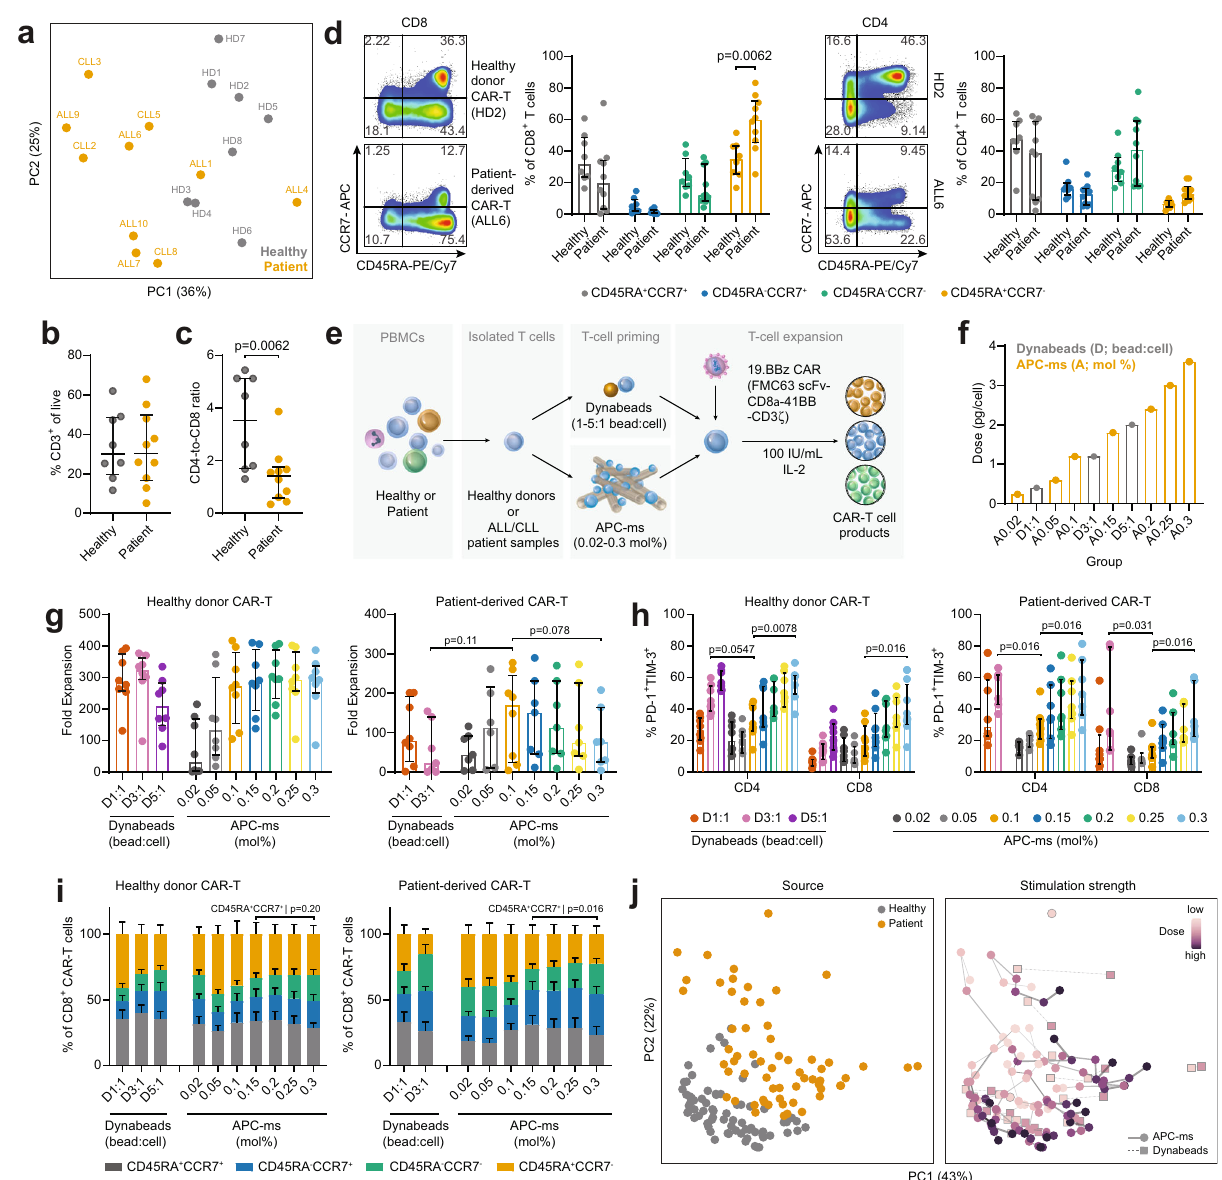
Fig. 1 | Stimulation strength and quality during T-cell activation drives the productionofdistinctCAR-Tcellproducts.a Principalcomponentanalysis(PCA) of blood samples stained using a standard 12-channel T-cell phenotyping FACS panel (Supplementary Fig. 1a) and colored by sample source in the PCA plot (healthy donor, HD; acute lymphoblastic leukemia, ALL; chronic lymphocytic leu- kemia, CLL). Frequency of CD3 + T cells ( b ), and CD4-to-CD8 ratio ( c ), in healthy or patient-derivedPBMC samples. d Proportions ofCD8 + and CD4 + T cellsstained for T-cell memory markers CD45RA and CCR7, highlighting increased fractions of CD45RA + CCR7 − CD8 + T cells in patient PBMC samples. Representative FACS plots for a healthy donor and patient sample are shown. e Schematic overview of CAR-T cell production pipeline. Isolated T cells were activated with arti fi cial antigen pre- senting cell-mimetic scaffold (APC-ms) across a progressively increasing range of stimulation dose (0.02 – 0.3mol%) or Dynabeads at a 1:1, 3:1, or 5:1 bead:cell ratio. Cells were transduced to express a second-generation CD19 CAR construct and expanded using exogenous IL-2 supplementation. f Anti-CD3/anti- CD28 stimulation measured in pg/cell across various APC-ms and Dynabead